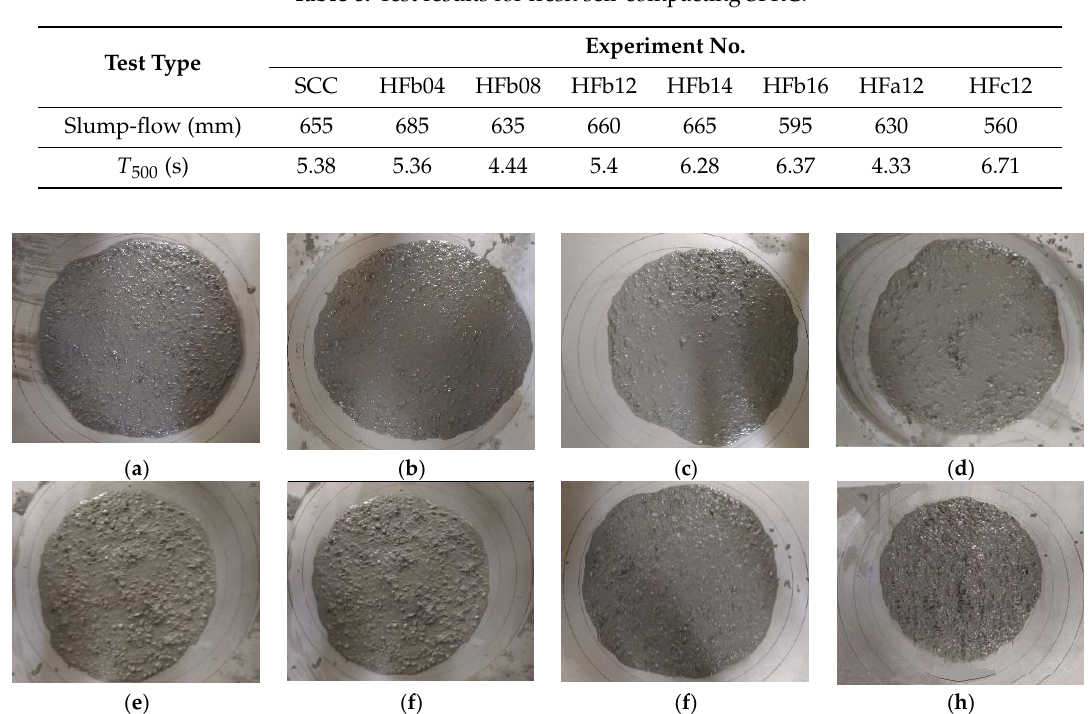
Figure 8. Pictures of slump flow tests. ( a ) concrete cake of reference SCC, ( b ) concrete cake of HFb04, ( c ) concrete cake of HFb08, ( d ) concrete cake of HFb12, ( e ) concrete cake of HFb14, ( f ) concrete cake of HFb16, ( g ) concrete cake of HFa12, ( h ) concrete cake of HFc12.